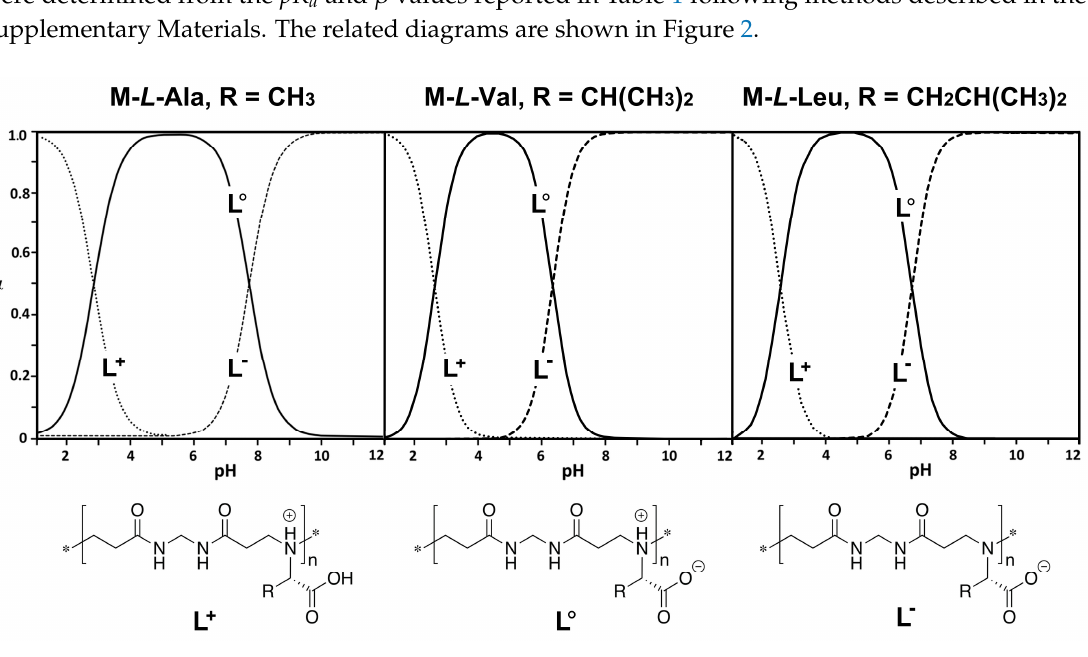
Figure 2. Speciation diagrams of M- L -Ala, M- L -Val and M- L -Leu.